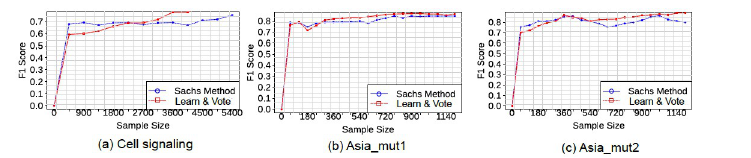
Fig 7. F1 vs. sample size for Learn and Vote and the Sachs et al. method, for three